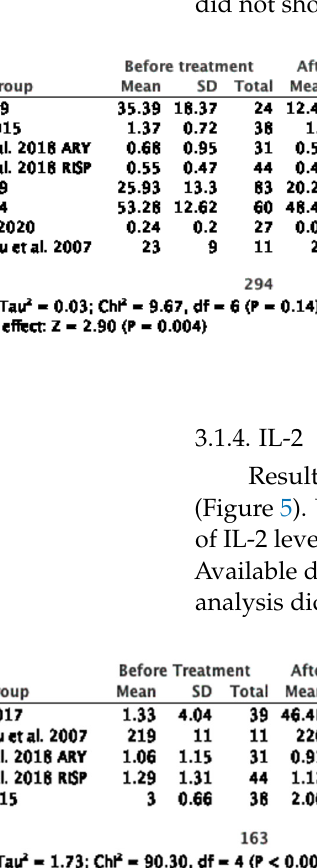
Figure 3. Meta-analysis of IL-17.